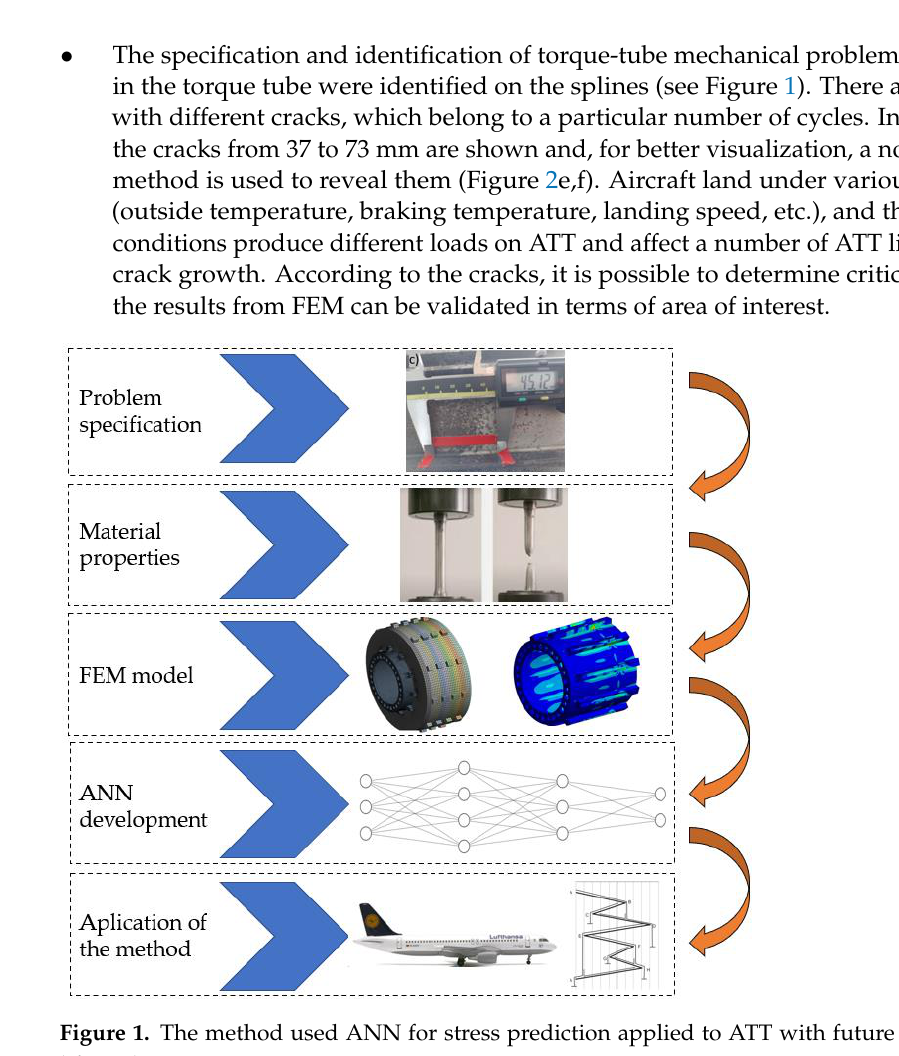
Figure 2. ATT cracks: ( a ) 25,000 cycles; ( b ) 17,000 cycles; ( c ) 36,000 cycles; ( d ) 17,000 cycles; ( e , f ) ATT cracks in the rib area visualized using a non-destructive technique. 3. ATT-Mechanical-Problem Identification—Method-Application Object Study presented in Figure 1 is applied on an Airbus A320 aircraft-brake part, which is aircraft torque tube (ATT). The brake and, thus, the ATT are parts of the retractable landing gear. The ATT is part of the brake, which is heavily stressed by fatigue load. Alt- hough it is made of solid material, it is exposed to a wide range of temperatures during its operation and, at the same time, it is subjected to pressure and shock during braking. The average number of life cycles for this component is around 30,000 from the operating